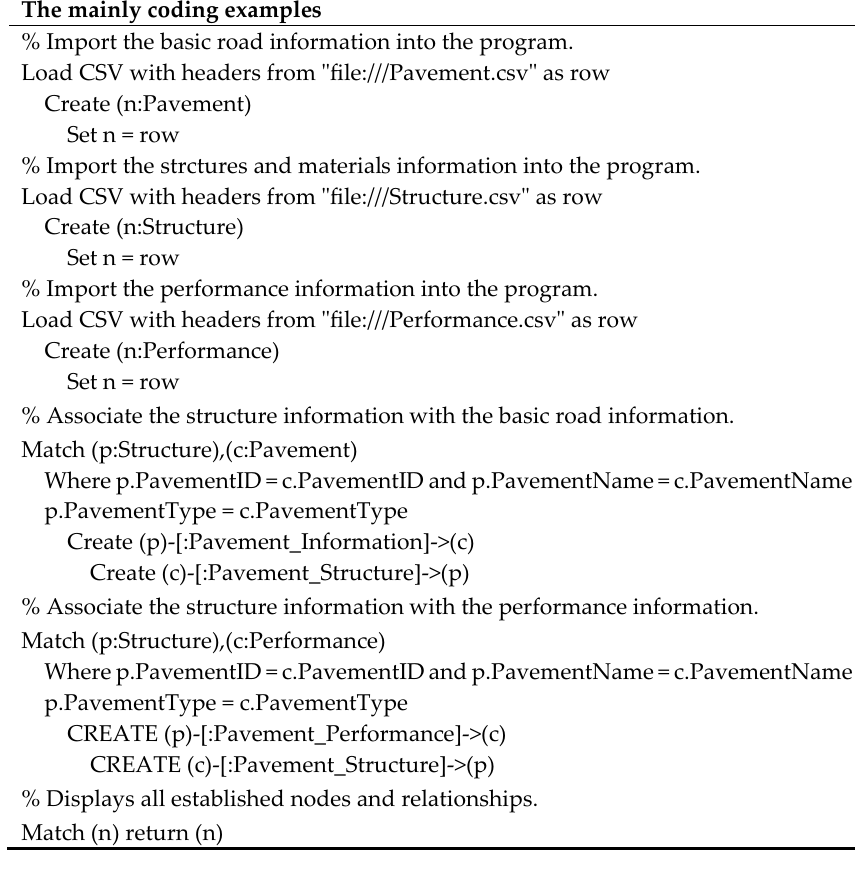
Table 2. The mainly coding examples for constructing knowledge